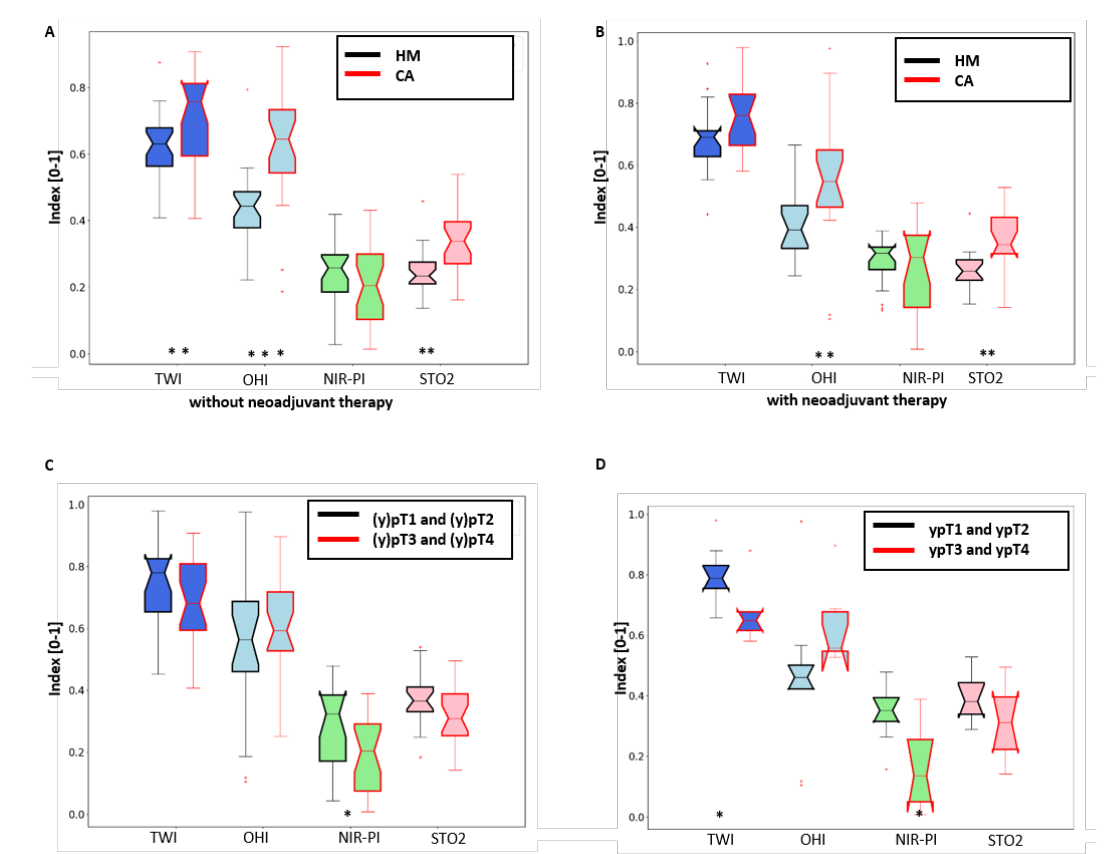
Figure 4. Comparison between physiological parameters TWI, OHI, NIR-PI, and StO 2 . ( A ) Comparison of healthy and cancerous tissue without neoadjuvant therapy. ( B ) Comparison of healthy and cancerous tissue with neoadjuvant therapy. ( C ) Comparison of cancerous tissue: (y)pT1 and (y)pT2 stage vs. (y)pT3 and (y)pT4 stage. ( D ) Comparison of cancerous tissue: ypT1 and ypT2 stage vs. ypT3 and ypT4 stage with neoadjuvant therapy.